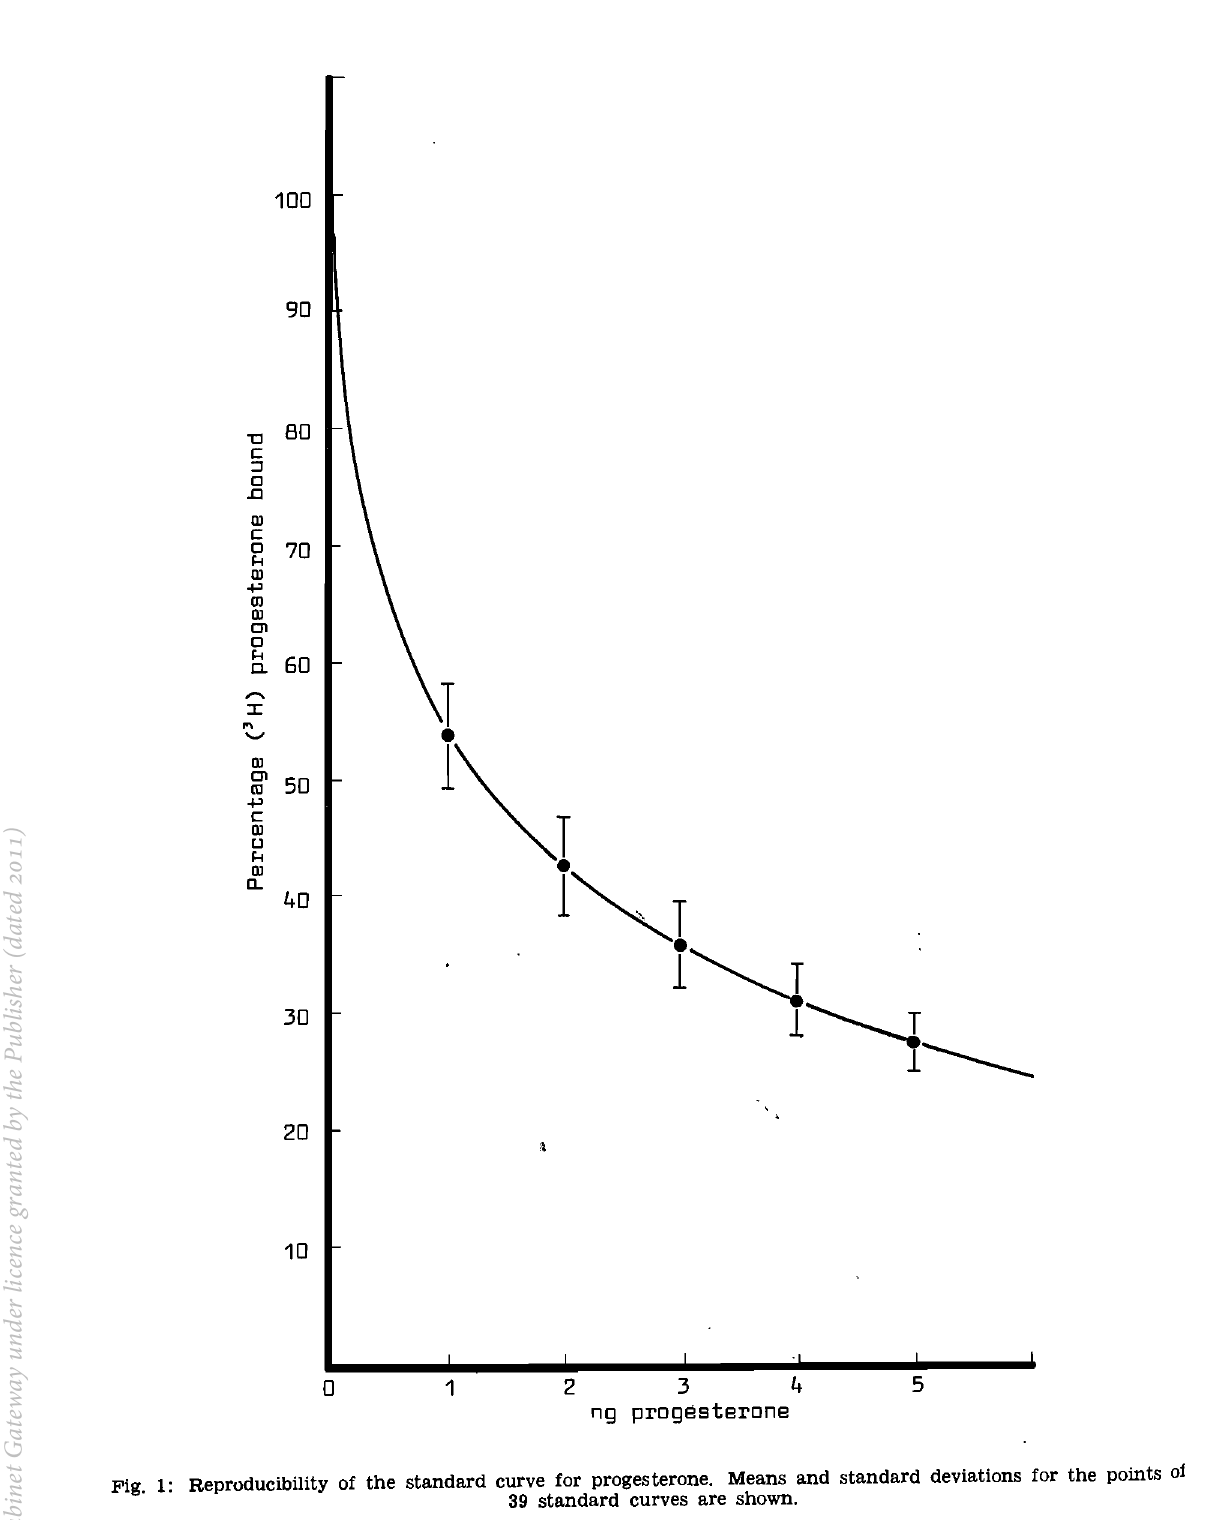
Fig. 1: Reproducibility of the standard curve for progesterone. Means and standard deviations for the points of 39 standard curves are shown.